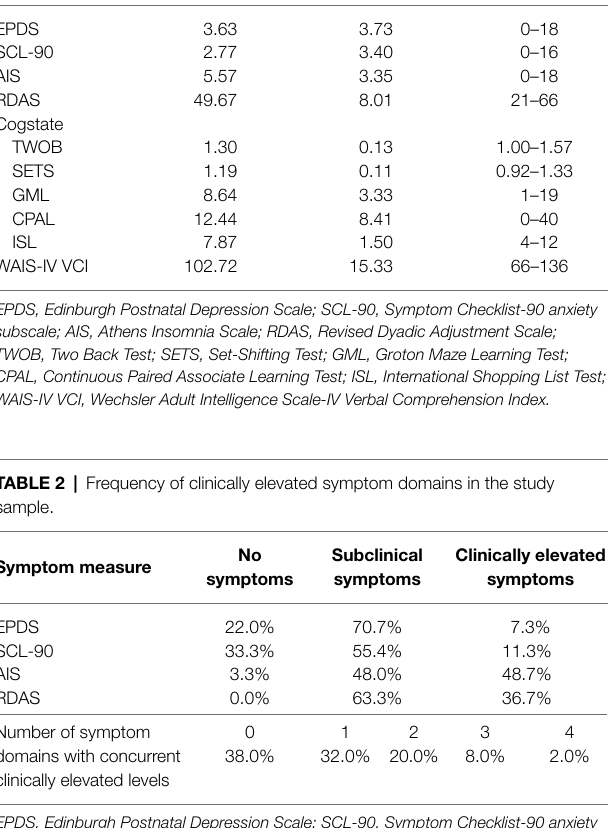
TABLE 1 | Mean values, standard deviations, and ranges for questionnaires and cognitive tests. Variable